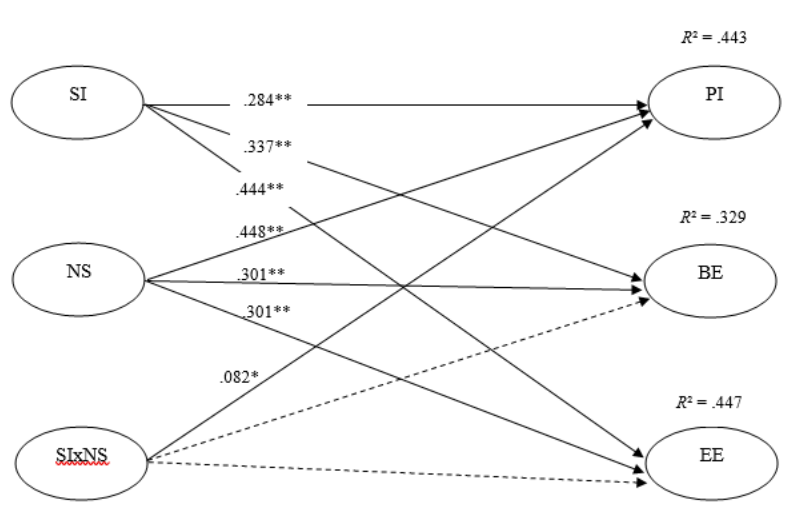
Figure 2 highlights findings from the Johnson-Neyman procedure, which provides clarity on the conditional relation between situational interest and personal interest. The relation between situational interest and personal interest was positive for students reporting need support, when SD scores were approximately -.05 or higher. In other words, there was not a statistically significant relationship between situational interest and personal interest for students who fell below the 30 th percentile in their reports of needs